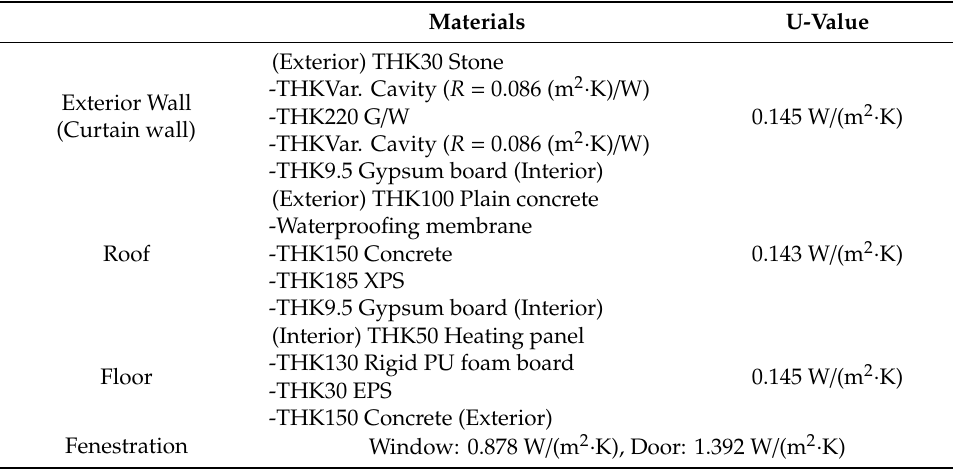
Table 5. U-values of the